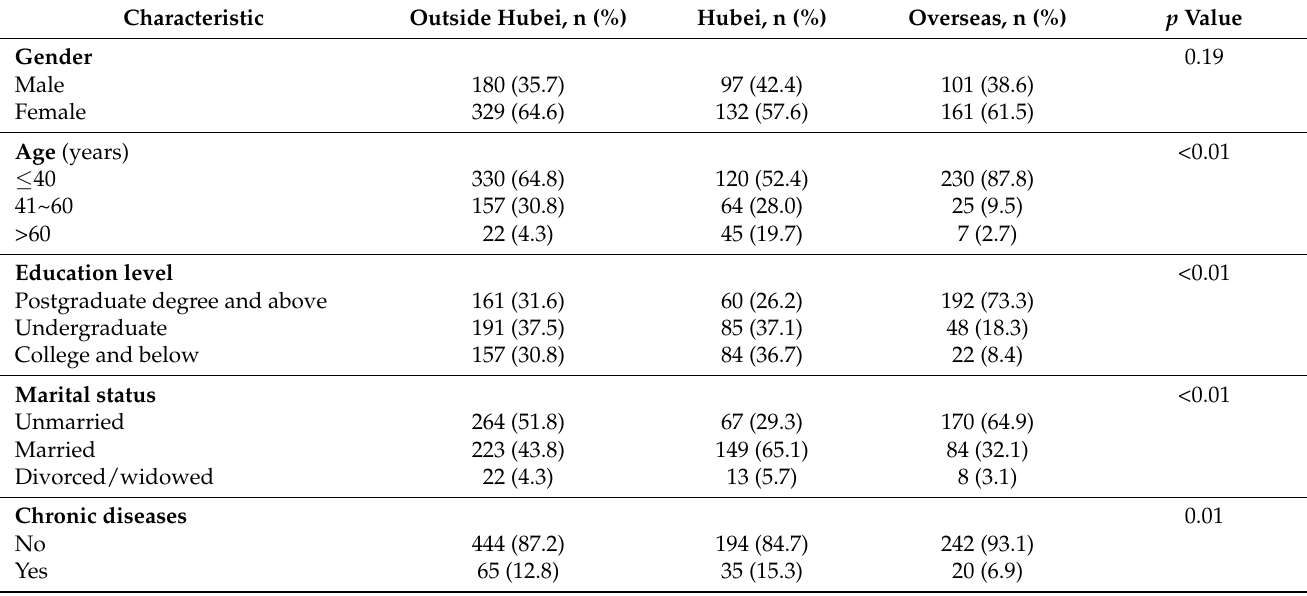
Table 1. Characteristics of respondents in the three